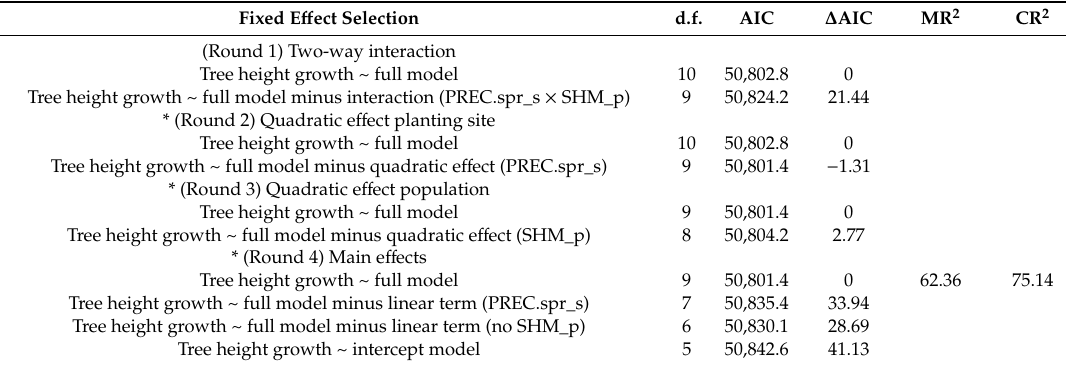
Table 2. Fixed e ff ects selection for the tree height growth model, following a hierarchical backward procedure using AIC [46] (see Section 2.4 for a detailed description). d.f.: degrees of freedom,